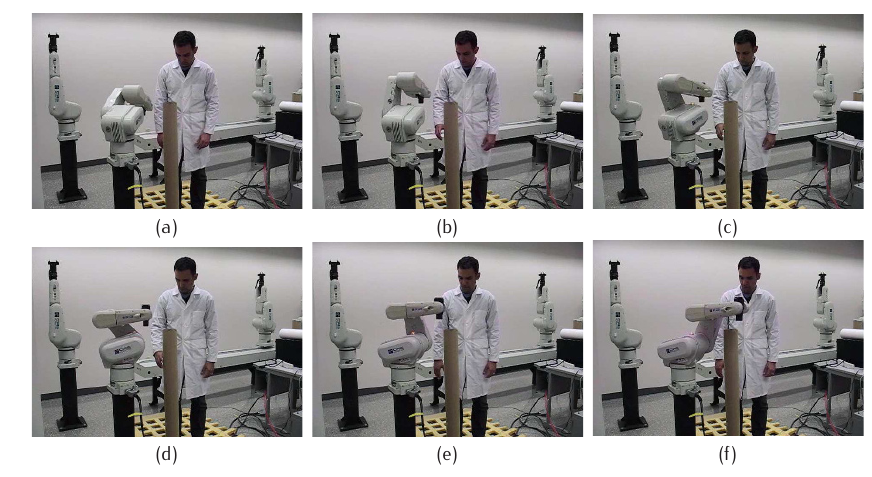
Figure 12. Snapshots of CRS-F3 arm while moving near a human and another object. (a) Start point, (b) and (c) moving around the human, (d) and (e) moving over the second obstacle, (f) reaching the goal